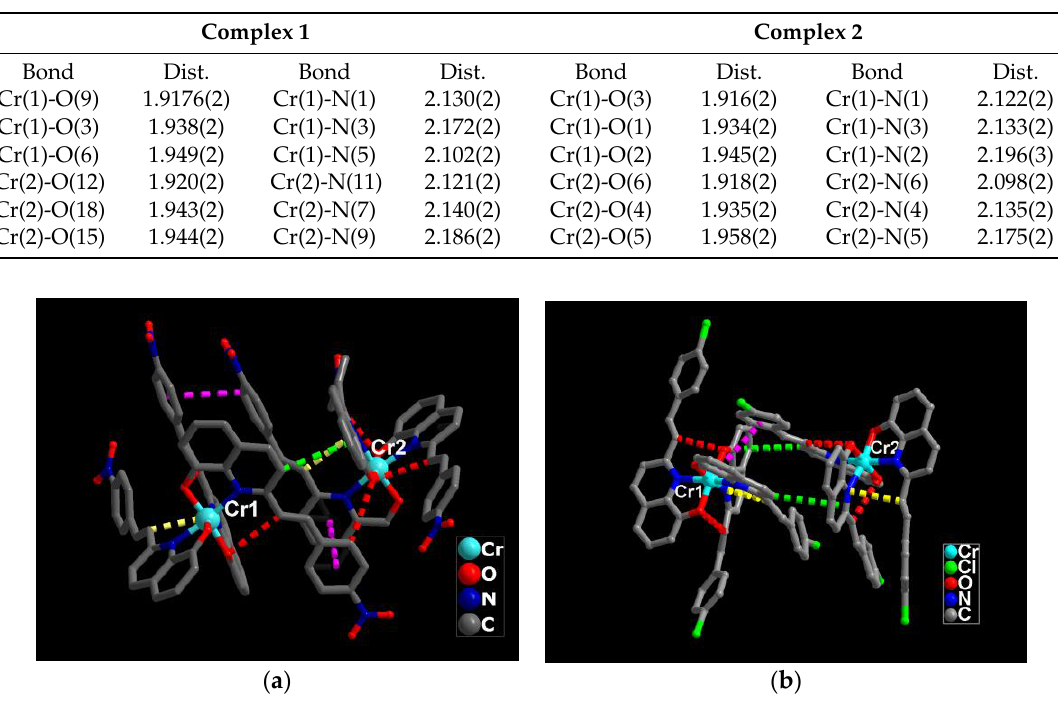
Figure 2. Views of the coordination geometries of Cr(III) atoms and the noncovalent interactions in the mononuclear complexes 1 ( a ) and 2 ( b ) (The intermolecular interactions are shown in different colors for clarity, the C-H···O, C-H···N, C-H···π and π···π stacking interactions were highlighted by red, yellow, green, and pink dotted lines, respectively).